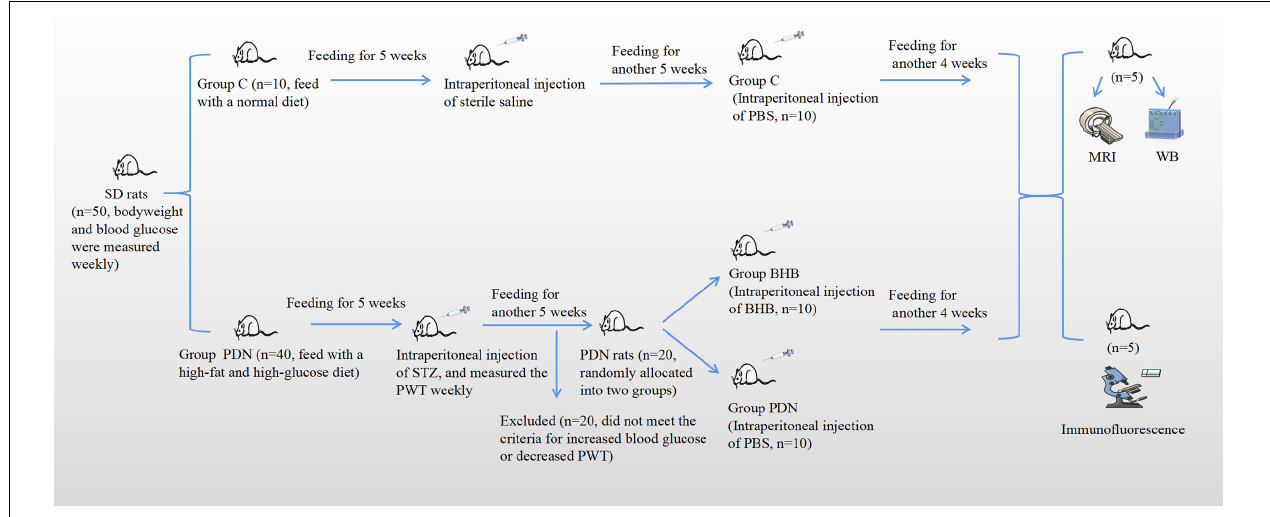
FIGURE 1 | The brief flowchart of the experimental design. Rats were fed for a total of 14 weeks. At the fifth week of feeding, rats in Group PDN were intraperitoneally injected with streptozotocin (STZ) and rats in Group C were intraperitoneally injected with sterile saline. At the 10th week of feeding, there were a total of 20 rats in Group PDN that were considered successfully modeled as PDN rats, and then they were randomly allocated into two groups (Group PDN, n = 10; Group BHB, n = 10). Afterward, rats in Group BHB were intraperitoneally injected with β -hydroxybutyrate (BHB), whereas rats in Group PDN and Group C were intraperitoneally injected with phosphate-buffered saline (PBS). It should be noted that at the end, 5 rats in each group underwent MRI and WB experiments successively. Finally, MRI, WB, and immunofluorescence were used to detect changes in function, expression level, and expression location. PWT means paw withdrawal